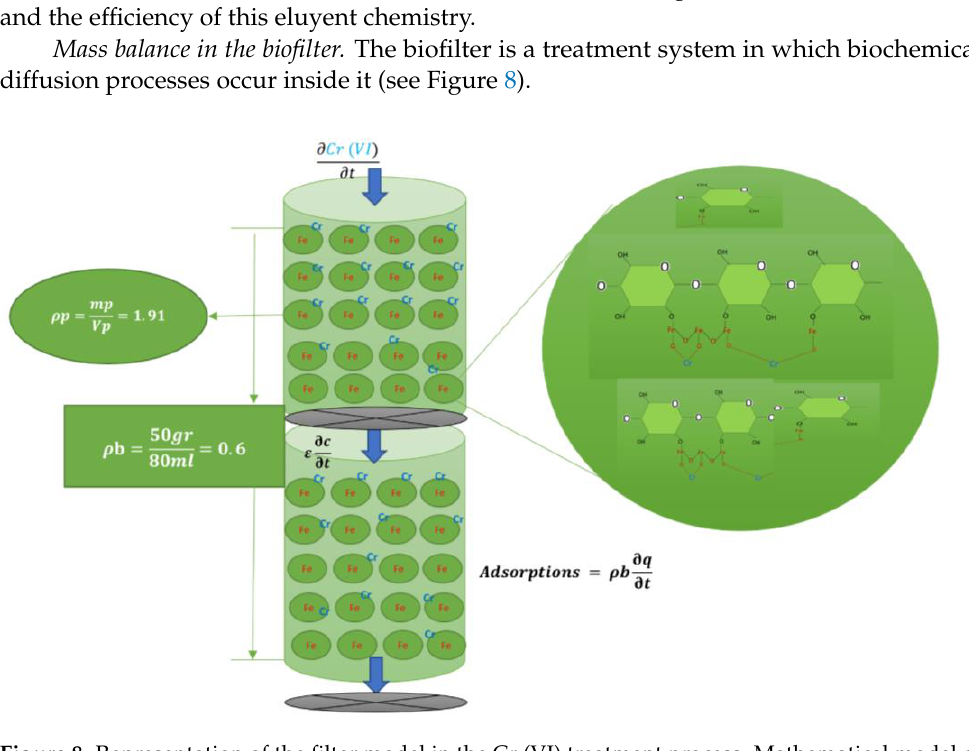
Figure 8. Representation of the filter model in the Cr (VI) treatment process. Mathematical model of input, output, and internal adsorption.